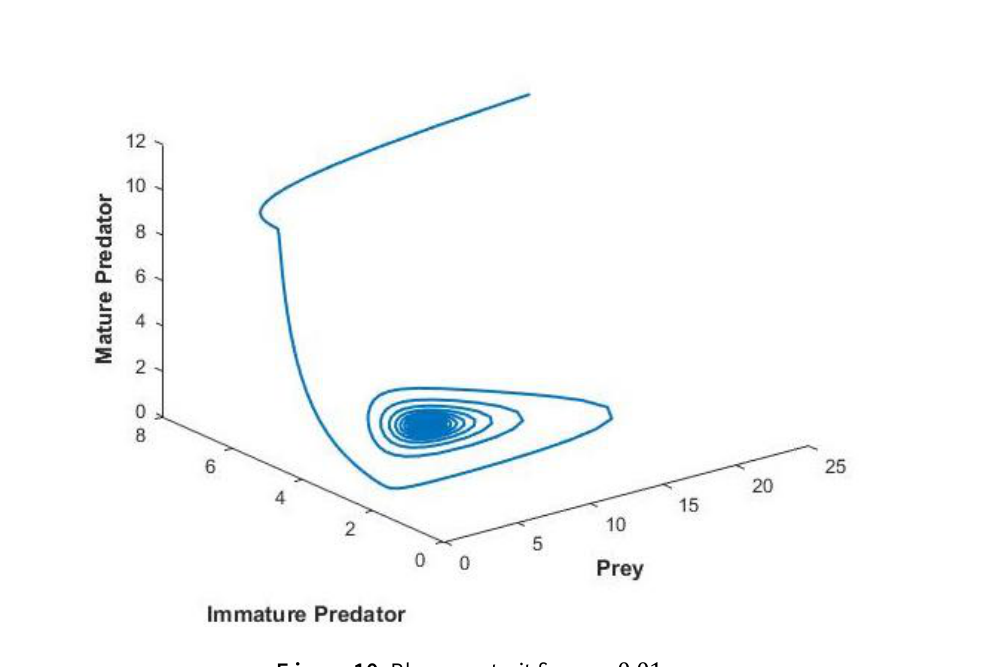
Figure 10. Phase portrait for 𝛾 = 0.01 .